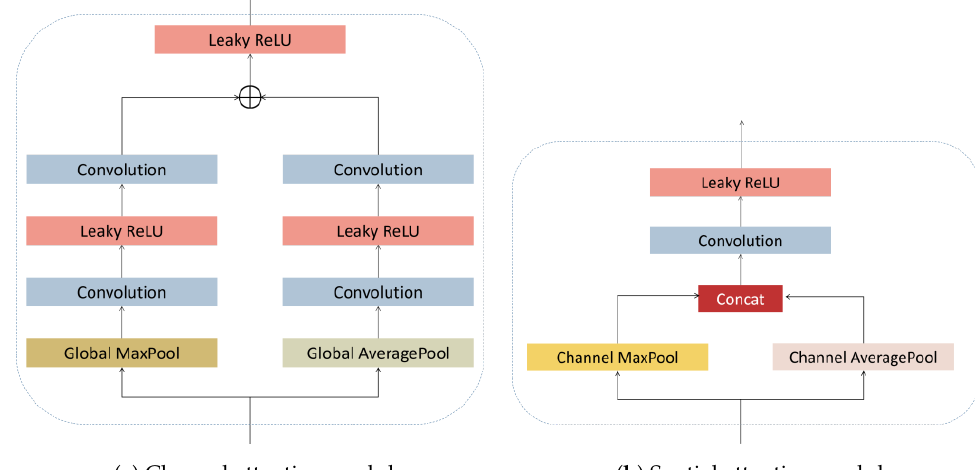
Figure 6. The architecture of the attention